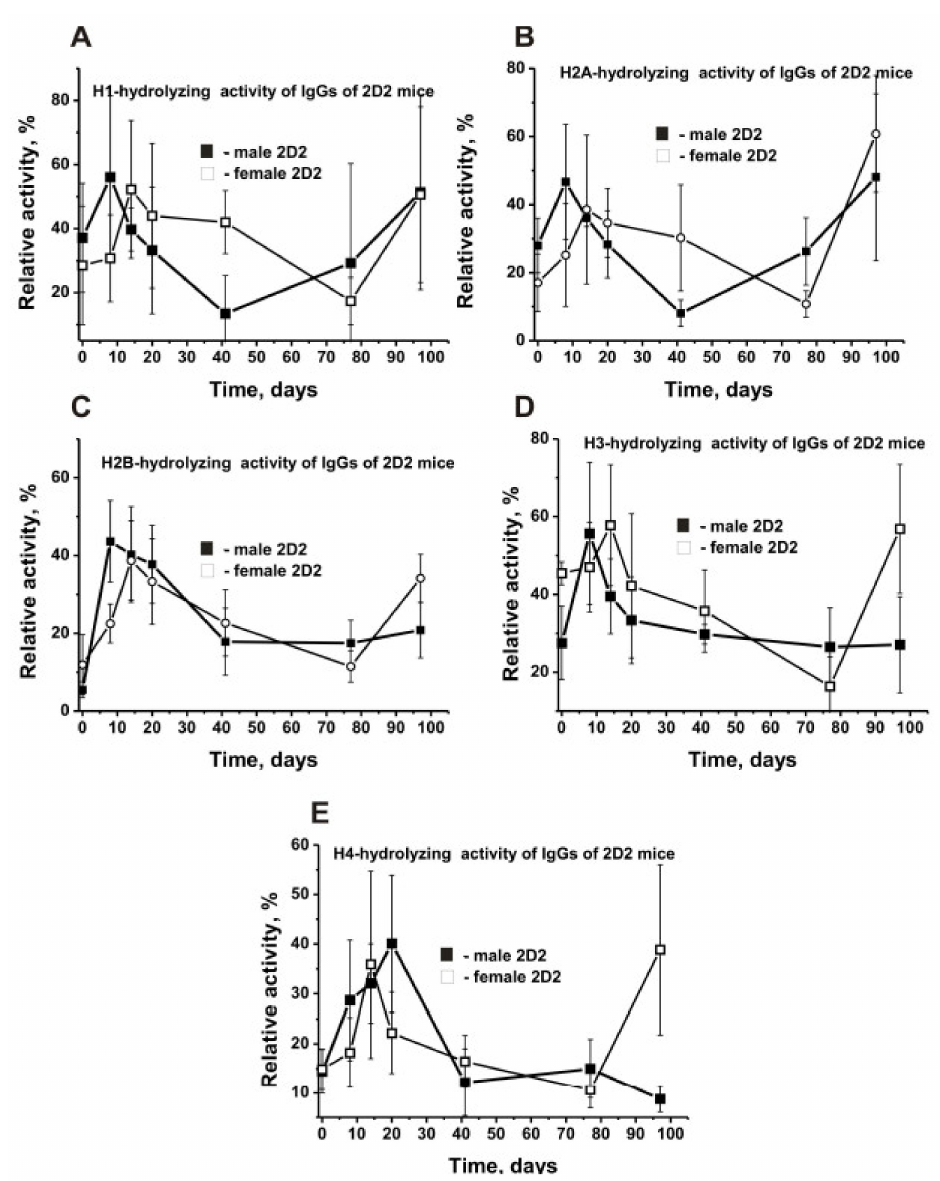
Figure 10. Time-related changes in the RA of IgGs in the hydrolysis of individual histones: H1 ( A ), H2A ( B ), H2B ( C ), H3 ( D ), and H4 ( E ). Dependencies corresponding to 2D2 male ( (cid:4) ) and female ( (cid:3) ) mice are marked in ( A – E )